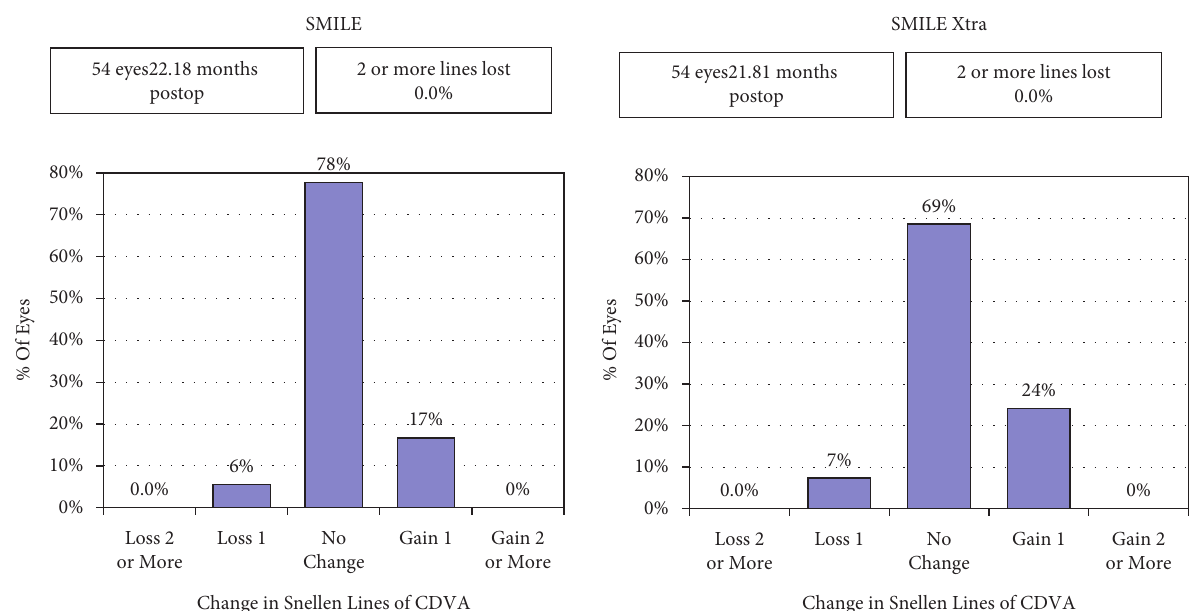
Figure 2: Histogram showing the change in the Snellen lines of corrected distance visual acuity